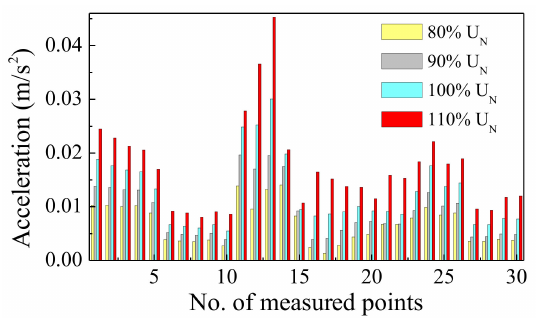
Figure 15. Comparison of acceleration under different no-load voltages.